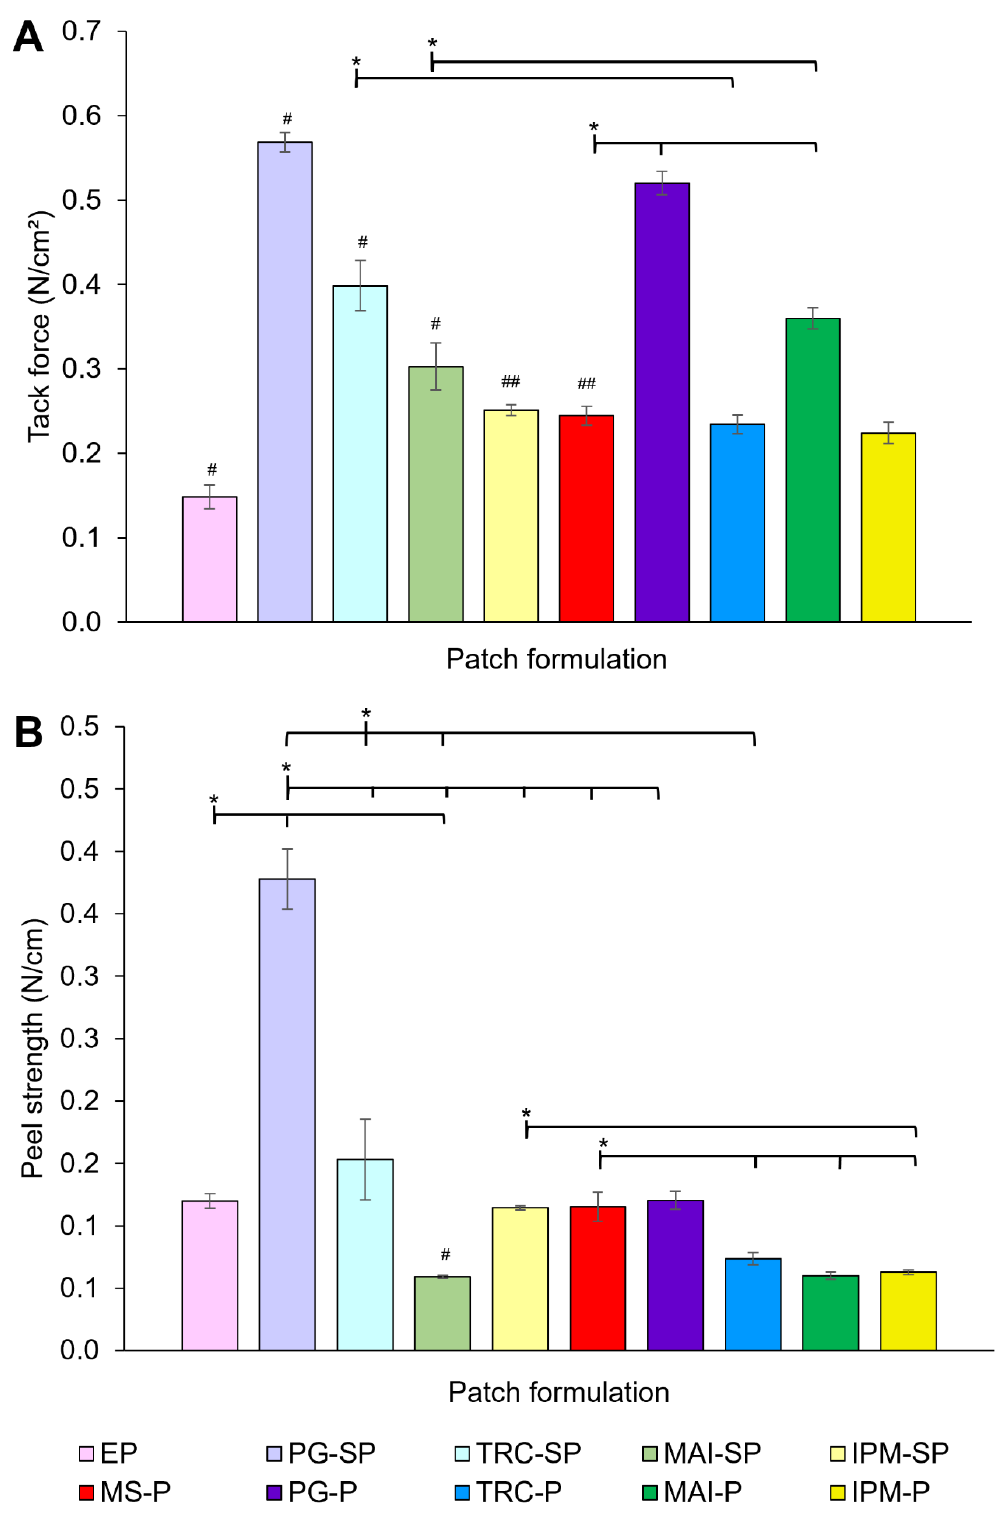
Figure 4. ( A ) Tack force and ( B ) peel strength of different patches prepared with and without solvent and/or drug (n = 3, mean ± SD; * p < 0.05, ANOVA; # statistically different comparing EP, -SP and MS-P; ## statistically different comparing EP, -SP and MS-P but not between the samples with the same symbols). PG: propylene glycol; TRC: Transcutol ® P; MAI: Maisine ® CC; IPM: isopropyl myristate; EP: patches without solvent and drug; MS-P: patches with drug but without solvent; -SP: patches with solvent only; -P: patches with drug and